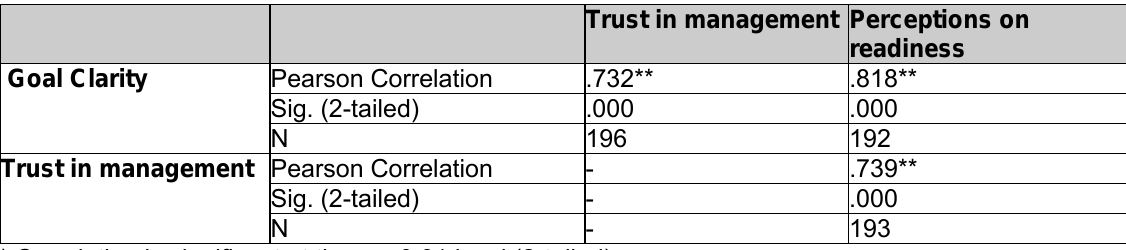
Table 5: Pearson correlation relationships between the three variables Trust in management Perceptions